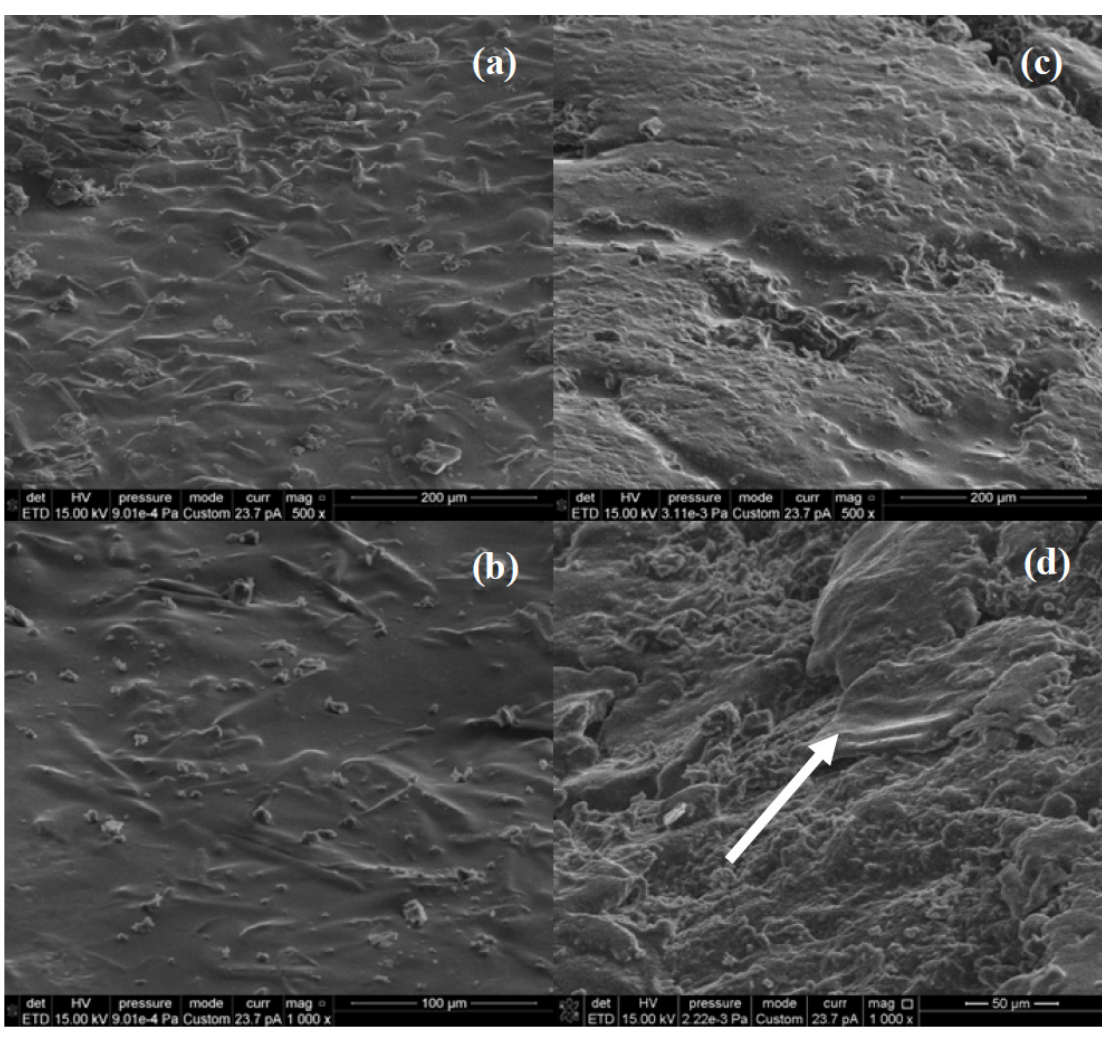
Figure 3. SEM images of AV5 ( a , b ) and AV10 ( c , d ) samples.